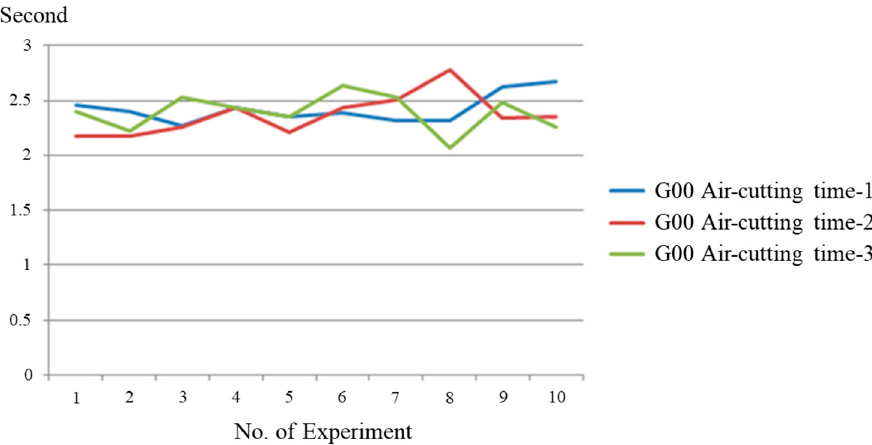
Figure 5. Monitoring result of G00 air cutting time.